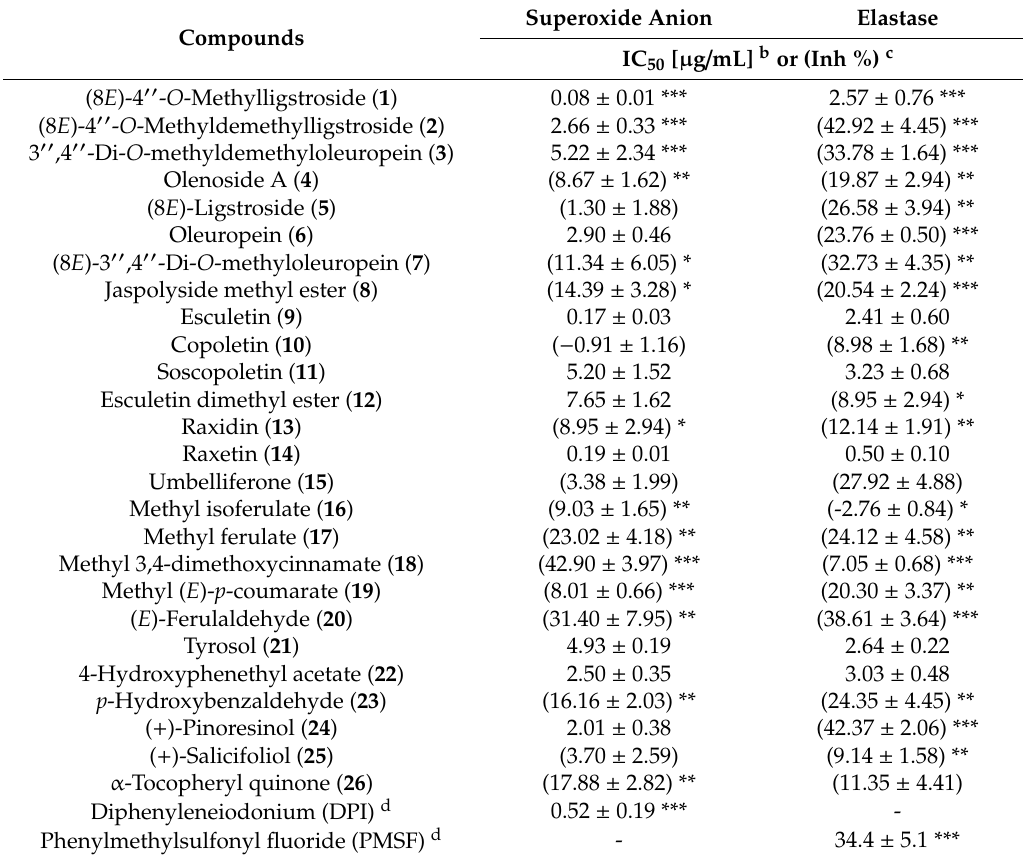
Table 3. Inhibitory effects of compounds 1 – 26 from the stem bark of F . chinensis on superoxide radical anion generation and elastase release by human neutrophils in response to fMet-Leu-Phe / cytochalasin B a